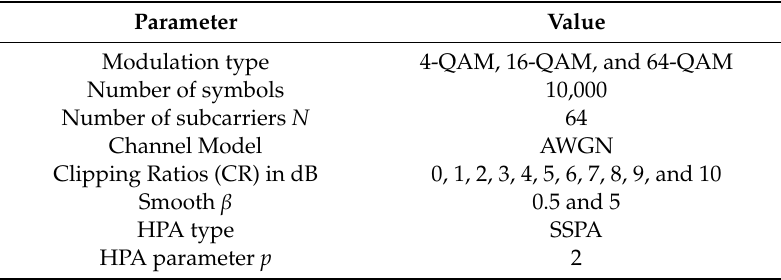
Table 1. Simulation parameters. QAM: Quadrature Amplitude Modulation.